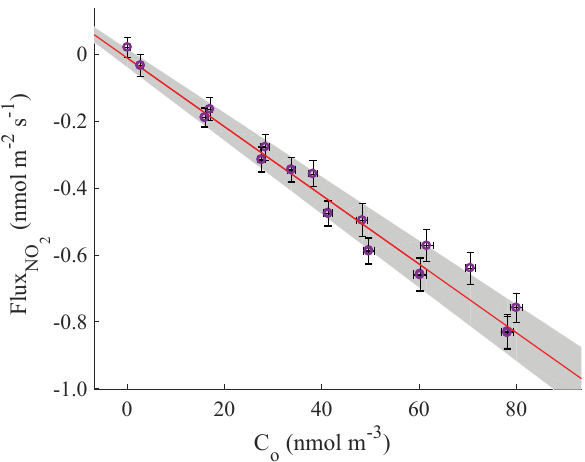
Figure 3. Flux to a 5.1cm diameter dish filled with activated char- coal. The chemical surface resistance to deposition is approximately zero, so the deposition velocity for deposition of NO 2 to the surface of the charcoal dish is the reciprocal of the boundary layer resis- tance. The line of best fit is ( 0 . 51 ± 0 . 032 )C o , where C o is the con- centration of NO 2 in the outgoing